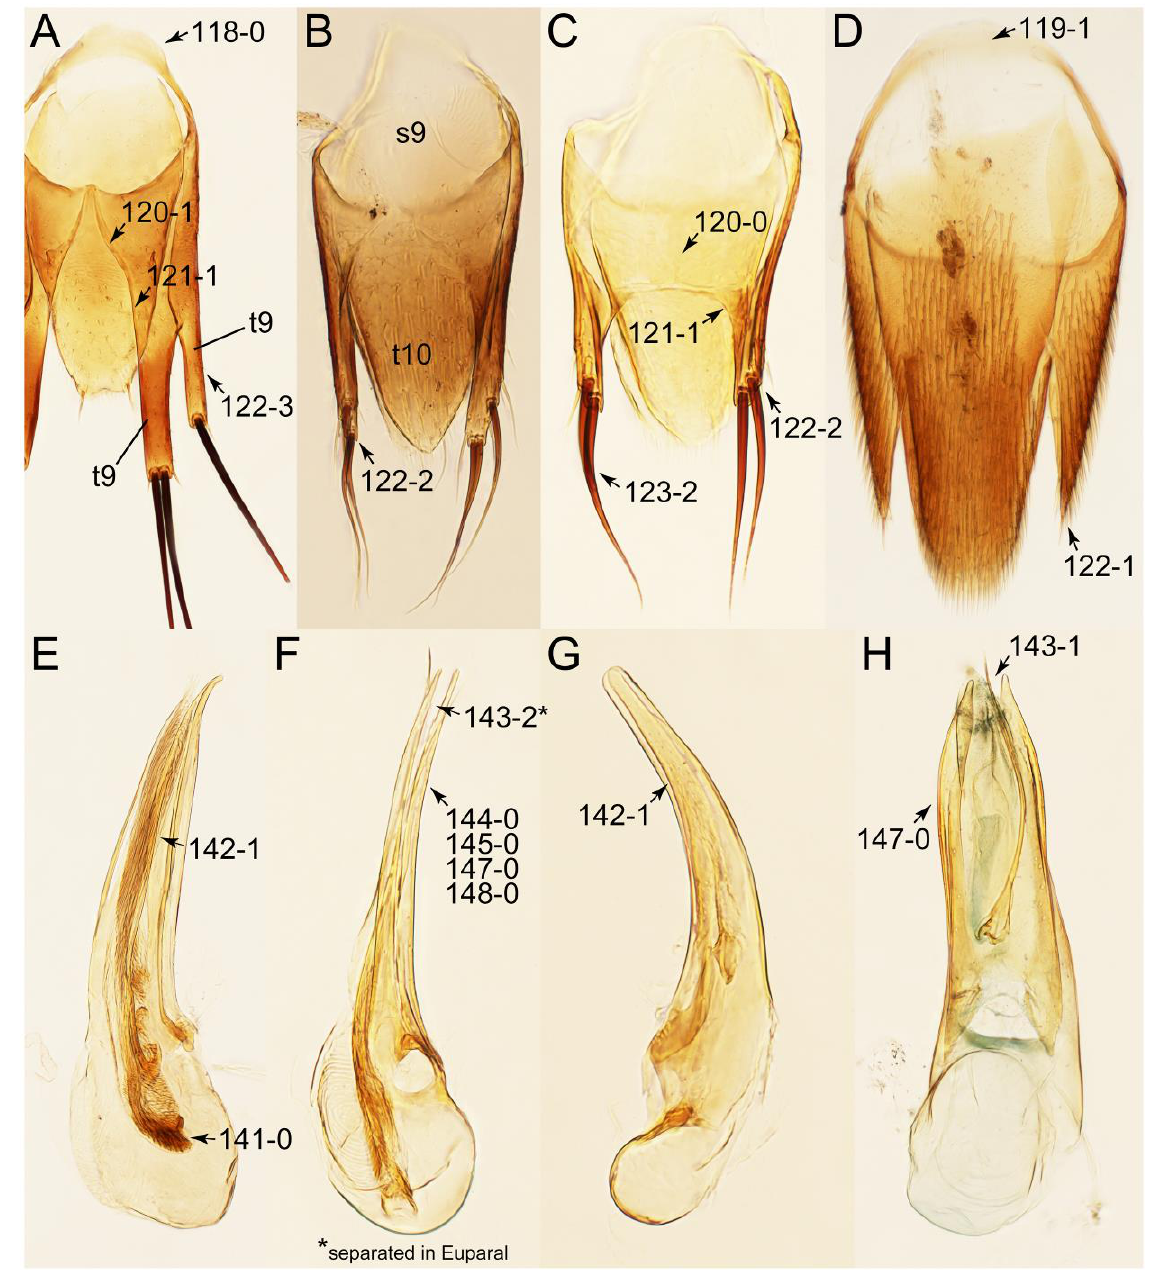
Figure 33. Photographs of body parts of Vatesini, male genital segments and aedeagus, enlarged. ( A ) tergite IX of Cilea limbifera , dorsal view. ( B ) tergites IX–X and sternite IX of Coprotachinus habrocerinus , dorsal view. ( C ) tergite IX of Mimocyptus sp., dorsal view. ( D ) tergite IX of Vatesus gigas , dorsal view. ( E ) aedeagus of Cilea silphoides , lateral view. ( F ) aedeagus of Coprotachinus habrocerinus , ventrolateral view. ( G ) aedeagus of Mimocyptus sp., lateral view. ( H ) aedeagus of Vatesus praedatorius , ventral view. Abbreviations: s9, sternite XI; t9–10, tergite IX–X. Characters and character states (format X-X) are indicated on each